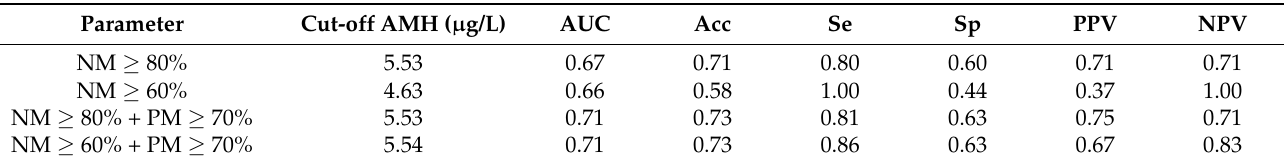
Table 2. Optimal cut-off point values with the greatest summation of sensitivity and specificity for different semen parameters.